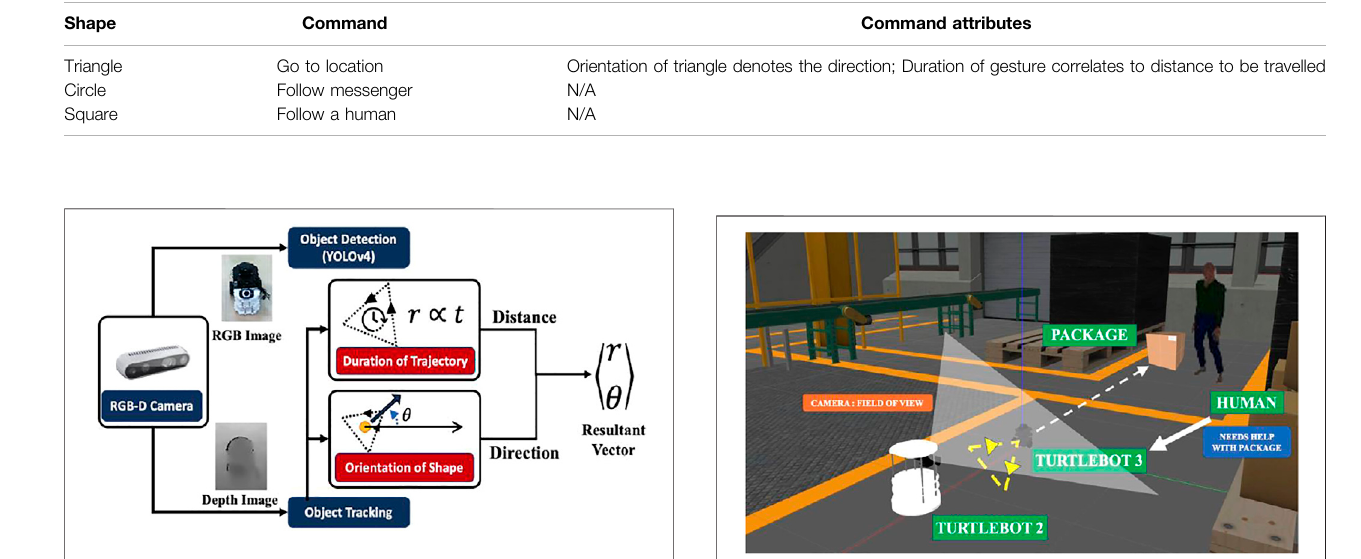
FIGURE4| SchematicforthemethodologyofGestureIdenti fi cationand Inference. FIGURE 5 | Simulation